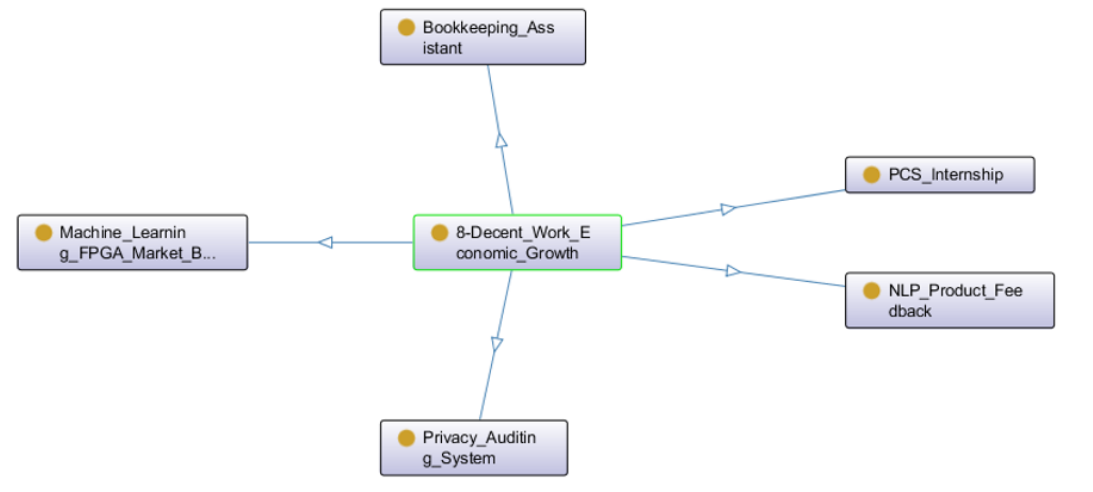
Figure 18. Projects related to the SDG 8.